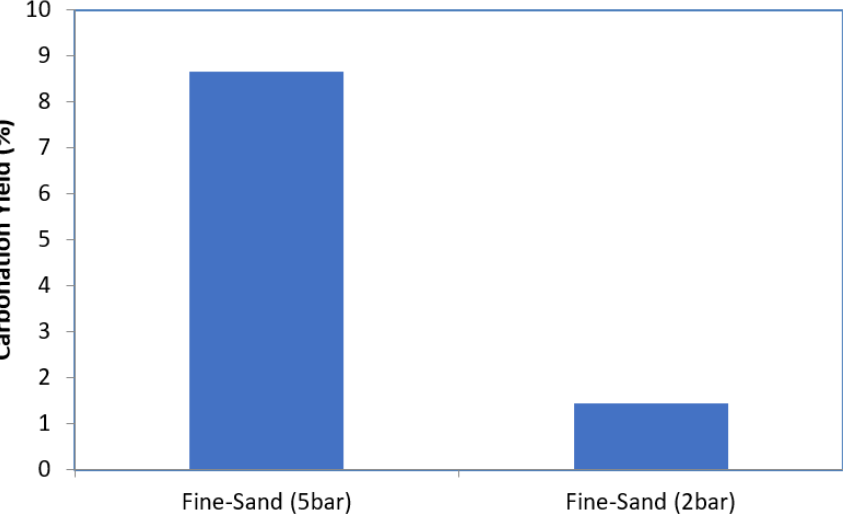
Figure 8. Carbonation yields in fine sand mortar at different pressures: 5 bar (104 h curing time, 6 h carbonation time) and 2 bar (110 h curing time, 7 h carbonation time).